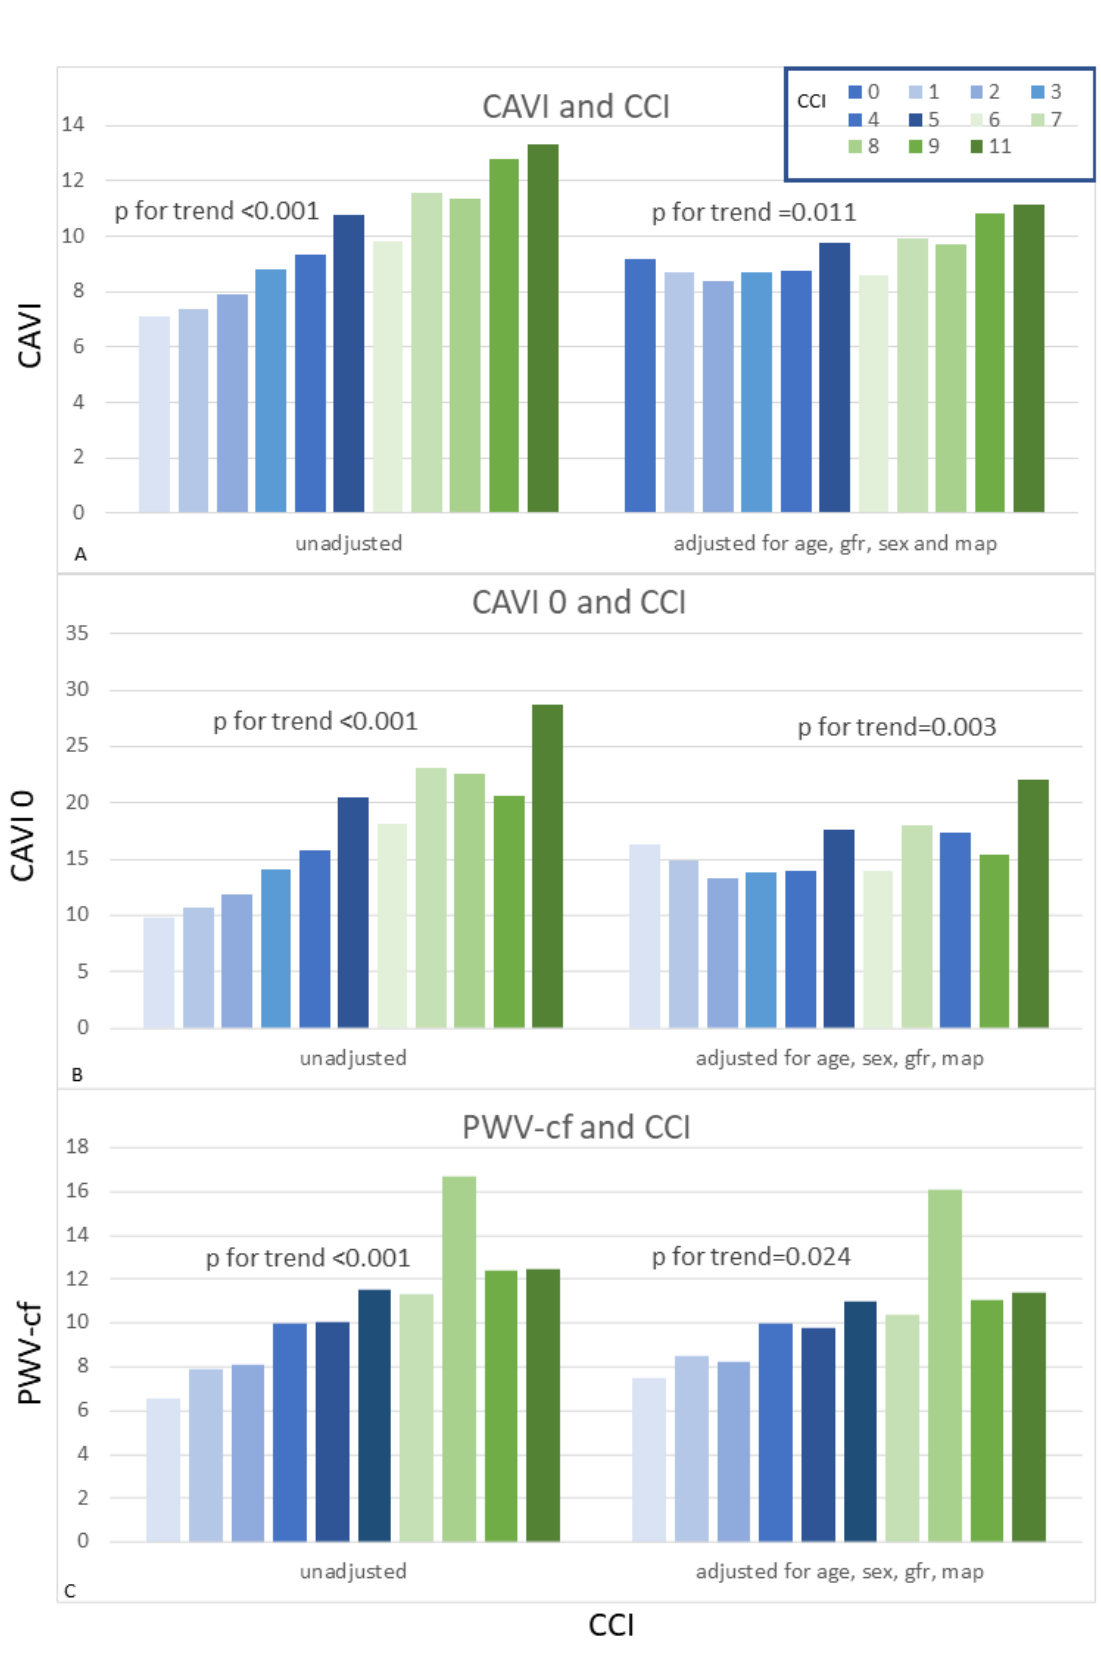
Figure 1. CAVI ( A ), CAVI 0 ( B ) and PWV-cf ( C ) values stratified by Charlson Comorbidity Index Columns represent increasing values of cci; on y axes arterial stiffness parameters are